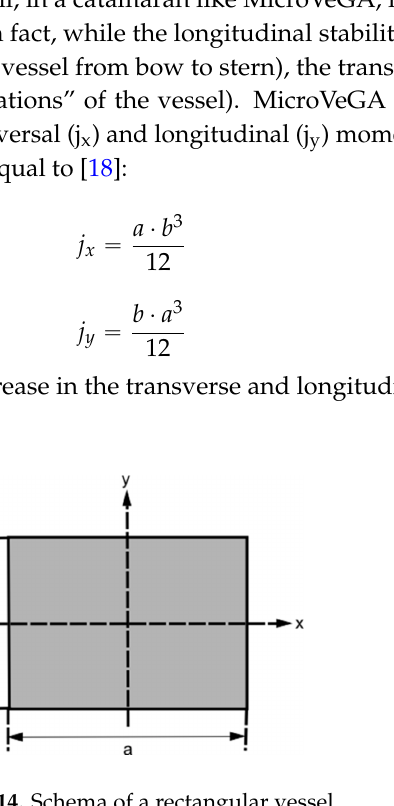
Figure 14. Schema of a rectangular vessel. Table 4. Comparison between physical characteristics of Prototypes #1 and #2.